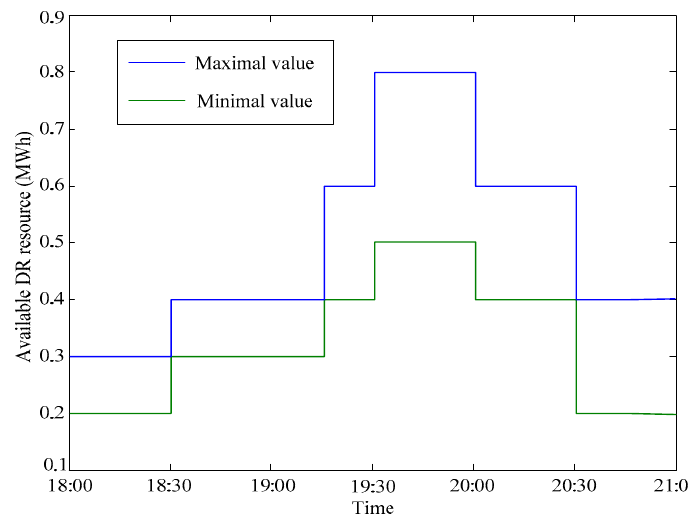
Figure 2. Range of available DR resource of each residential community.